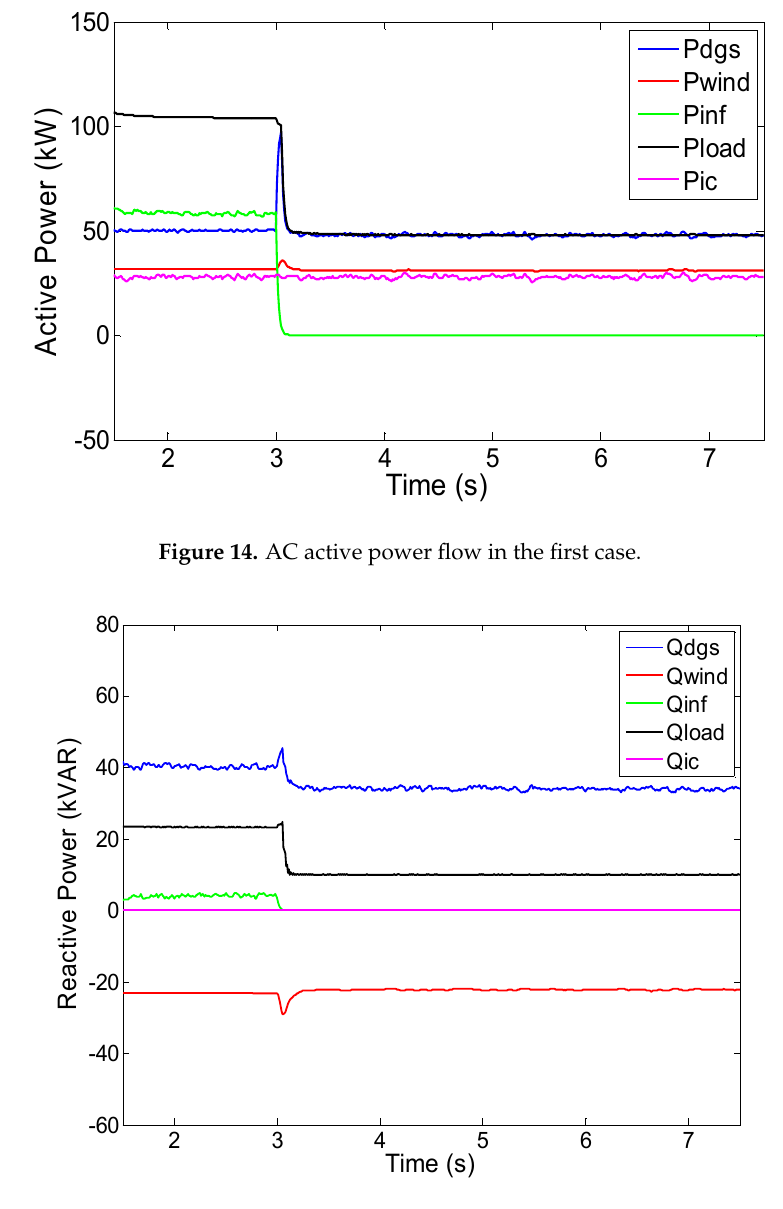
Figure 15. AC reactive power flow in the first case.